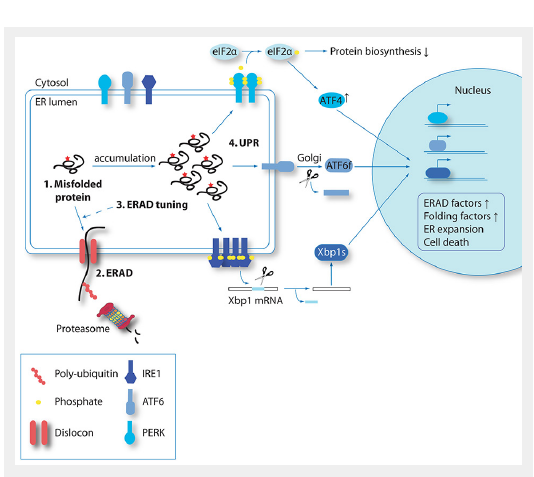
Responses to misfolded proteins in the ER. Misfolded protein species can arise due to the error-proneness of the folding process